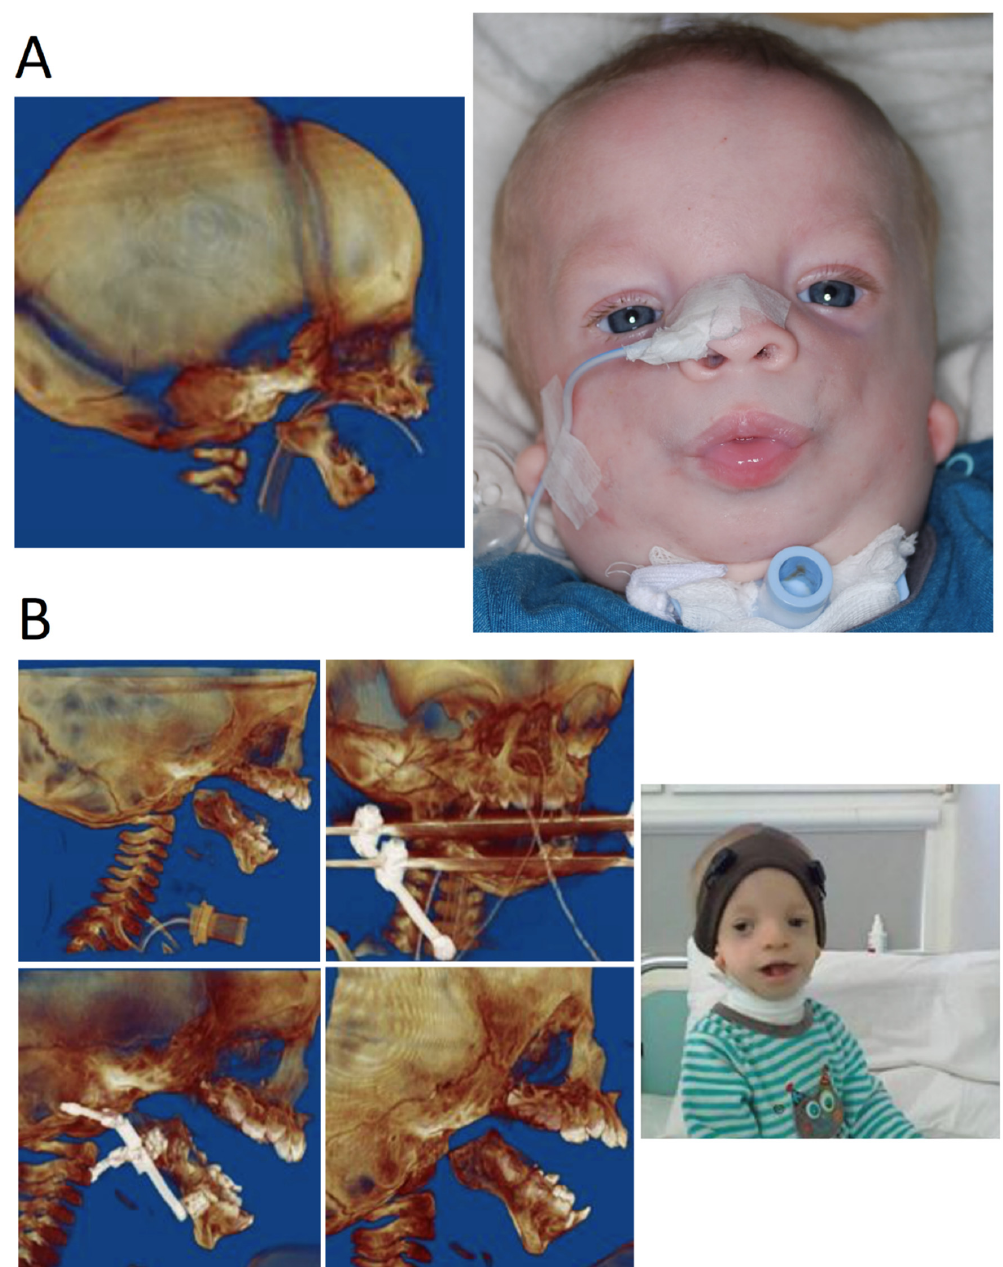
Figure 4. The same patient at different ages during different stages of treatment. ( A ) Infant with TCS, CT image of 3D reconstruction, patient with tracheostomy. ( B ) Few years-old patient. 3D images of reconstruction during treatment— multistage mandibular osteodistraction; patient after completion of osteodistraction process, removed tracheostomy tube.